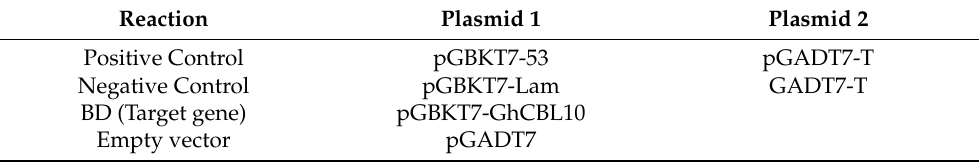
Table 1. The bait auto-activation and toxicity test